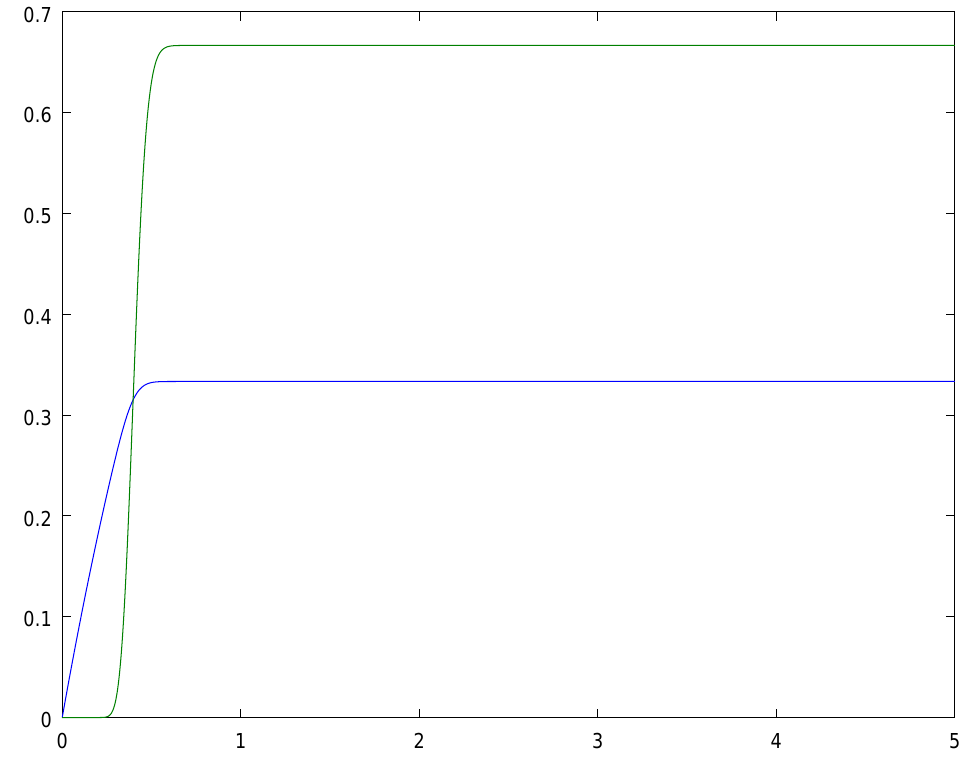
Figure 4. Example 1 (ii). Time is marked on the horizontal axis, and the probabilities q 0 ( t ) (green) and ( t ) (blue) are marked on the vertical axis. q 0 (cid:48) ≈ q ( 5 ) ≈ 0.33333 and Q We have P ( A ) = Q 0 (cid:48) 0 (cid:48) probability